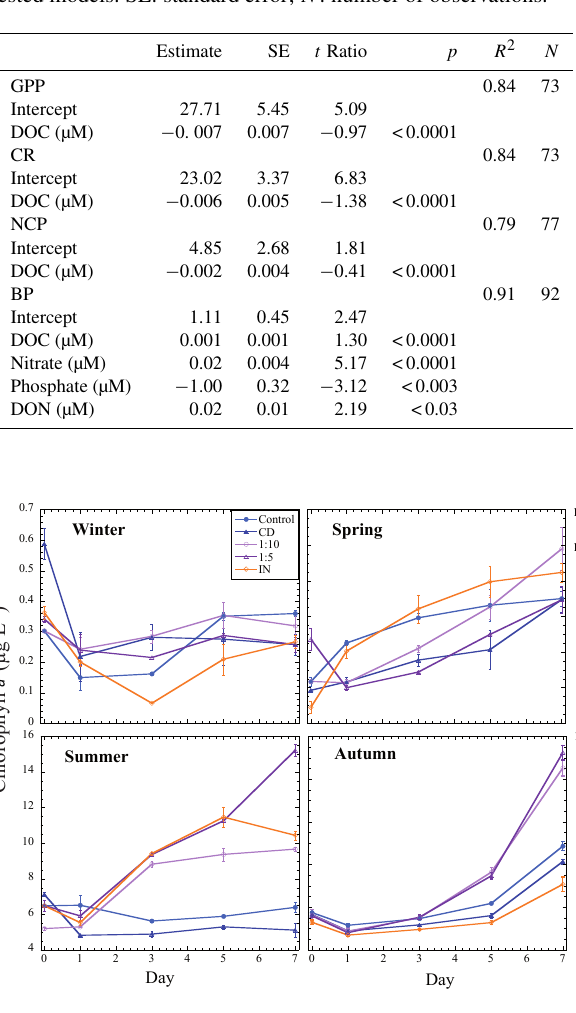
Figure 1. Chlorophyll a content for the different incubation days and different treatments for the four